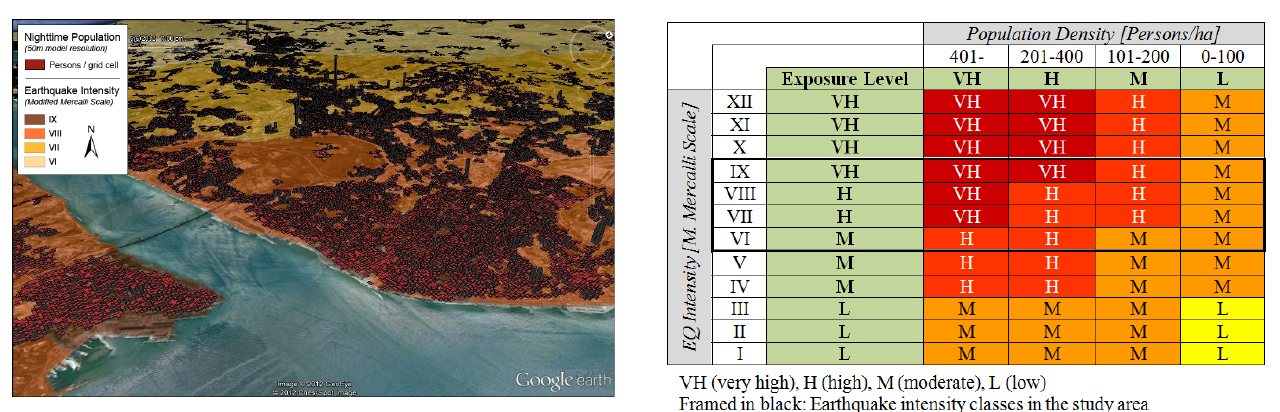
Fig. 5. Classification approach to categorize human exposure